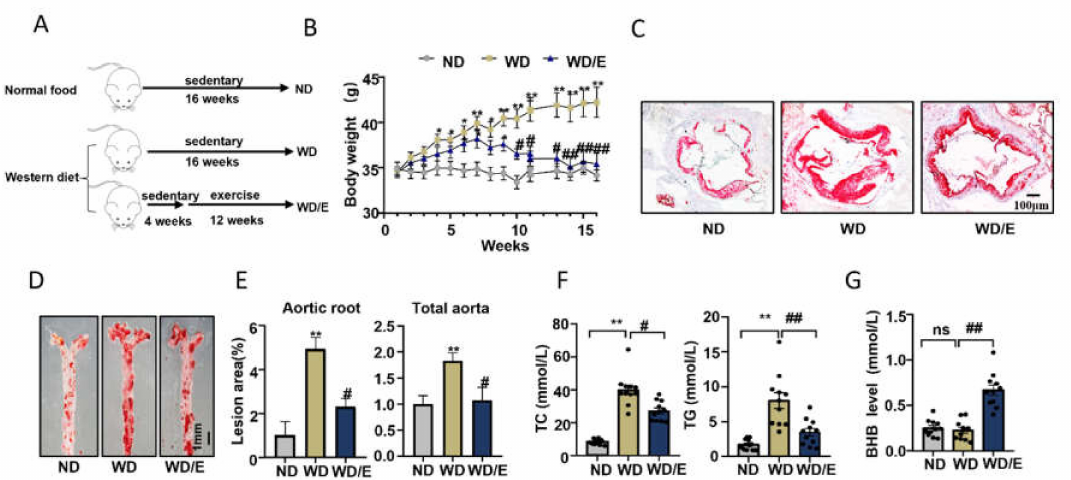
Figure 1. Exercise inhibits the development of atherosclerosis and increases serum BHB levels. ( A ) ApoE − / − mice were fed normal food (ND) or a Western diet (WD), and either had access to exercise (E) for 12 weeks or did not (sedentary) ( B ) Body weight of mice (n = 11). ( C ) Representative images of the cross-sections of the aortic root stained with Oil Red O. Scale bars, 100 µ m. ( D ) Repre- sentative images of the whole aorta stained by Oil Red O. Scale bars, 1 mm. ( E ) Quantification of cross-sections of the lesion area in the aortic root and whole aorta (n = 6). ( F ) Total cholesterol (TC) and triglycerides (TG) in the serum of ApoE − / − mice (n = 11). ( G ) BHB levels in the serum from the mice (n = 11). Data are represented as means ± SEM. * p < 0.05, ** p < 0.01 vs. ND mice, and # p < 0.05, ## p < 0.01 vs. WD mice, ns is no